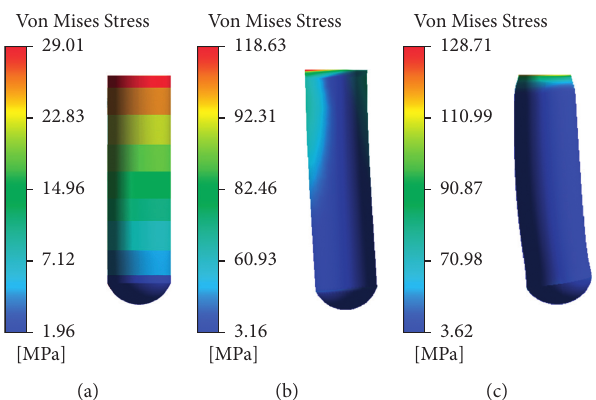
Figure 11: Contours of equivalent stress distribution of thermowell in equilibrium state. (a) Temperature load. (b) Pressure load. (c) Temperature + pressure